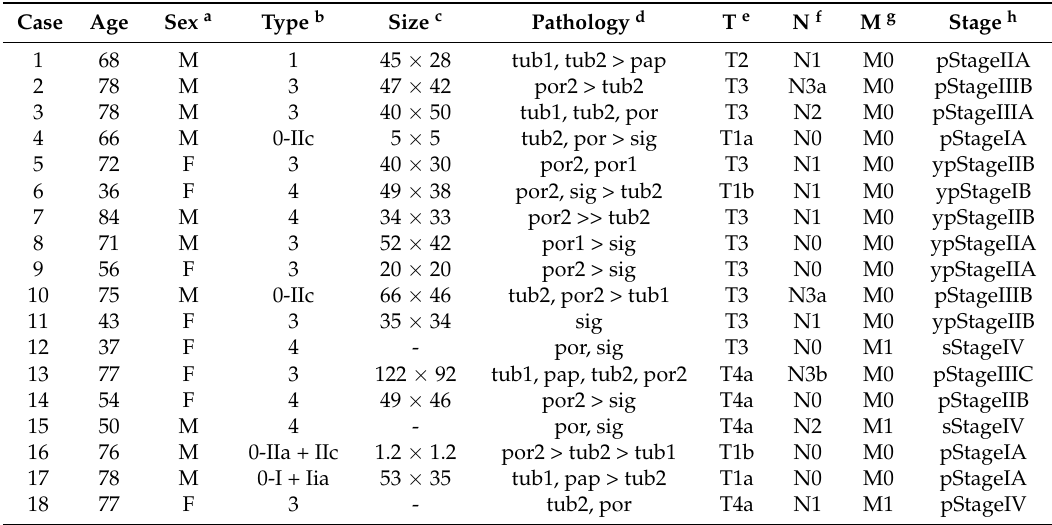
Table 4. Clinical and pathological features of gastric cancer